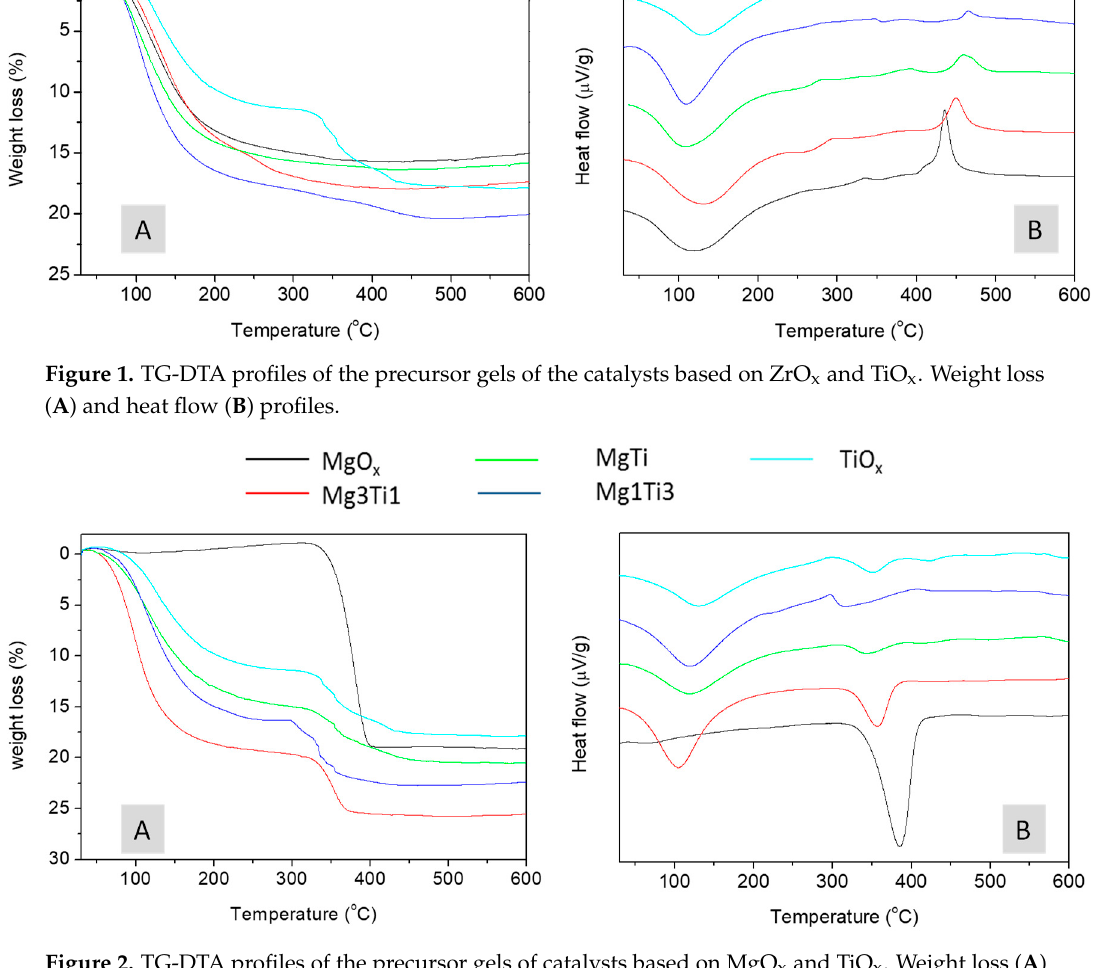
Figure 2. TG-DTA profiles of the precursor gels of catalysts based on MgO x and TiO x . Weight loss ( A ) and heat flow ( B ) profiles.